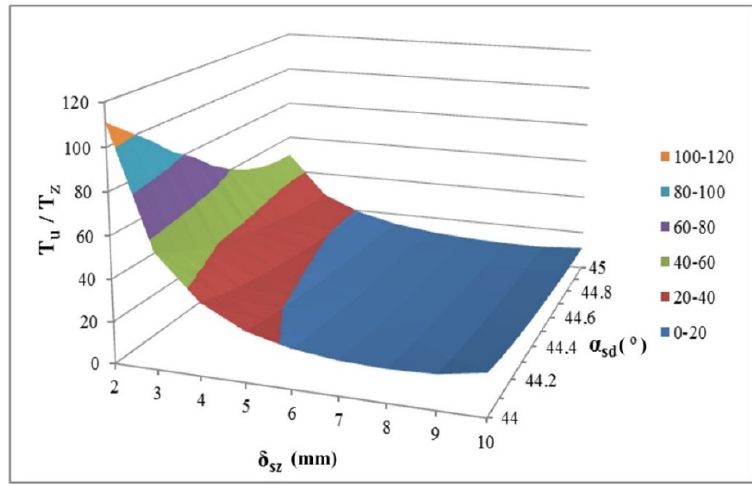
Figure 8. 3D graph for the T u /T z coefficient for the asymmetric DCPM motor.